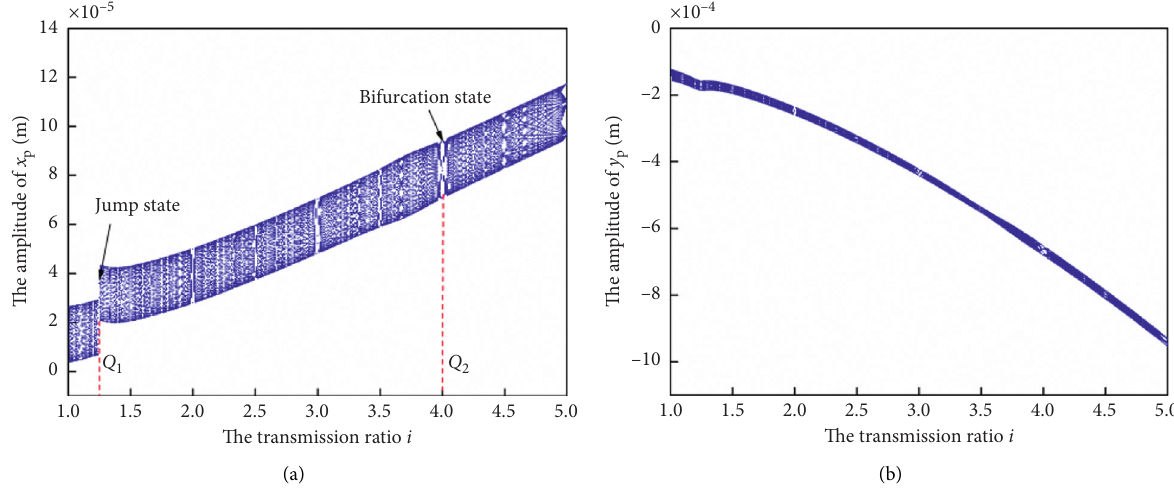
m with the change of transmission ratio.